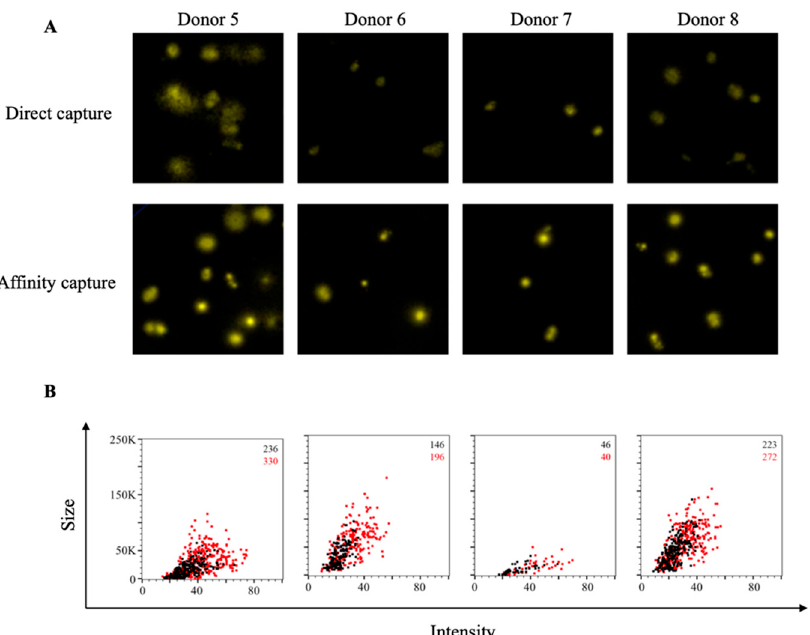
Figure 4. Improved sensitivity of EBNA1-specific ASC through affinity capture of coating antigen. PBMC were stimulated in vitro and evaluated for antibody-secreting (ASC) reactivity against the Epstein–Barr nuclear antigen 1 (EBNA1) protein from EBV. ( A ) Representative well images depicting antigen-specific IgG + ASC in wells coated directly with 10 µ g/mL of EBNA1 protein or through affinity capture using the genetically encoded hexahistidine (6XHis) tag. Magnification and contrast enhancements were uniformly performed on all images to aid their visualization in publication. ( B ) EBNA1-specific FluoroSpots were merged into FCS files and visualized as bivariate plots. FluoroSpots originating from assay wells in which EBNA1 protein was directly captured on the membrane (black dots) or through affinity capture (red) are shown as overlays. The combined number of FluoroSpots detected in replicate wells for each of the respective donors is indicated in the inset using the same red/black color code.